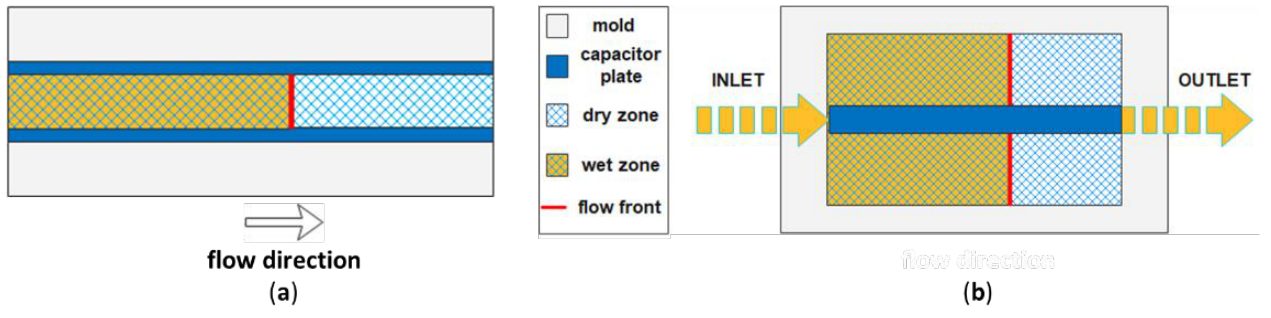
Figure 9. ( a ) Experimental set-up for flow front monitoring with a parallel-plate capacitor and ( b ) sketch of in-plane flow front advancement (adapted from Qi et al. [80]).